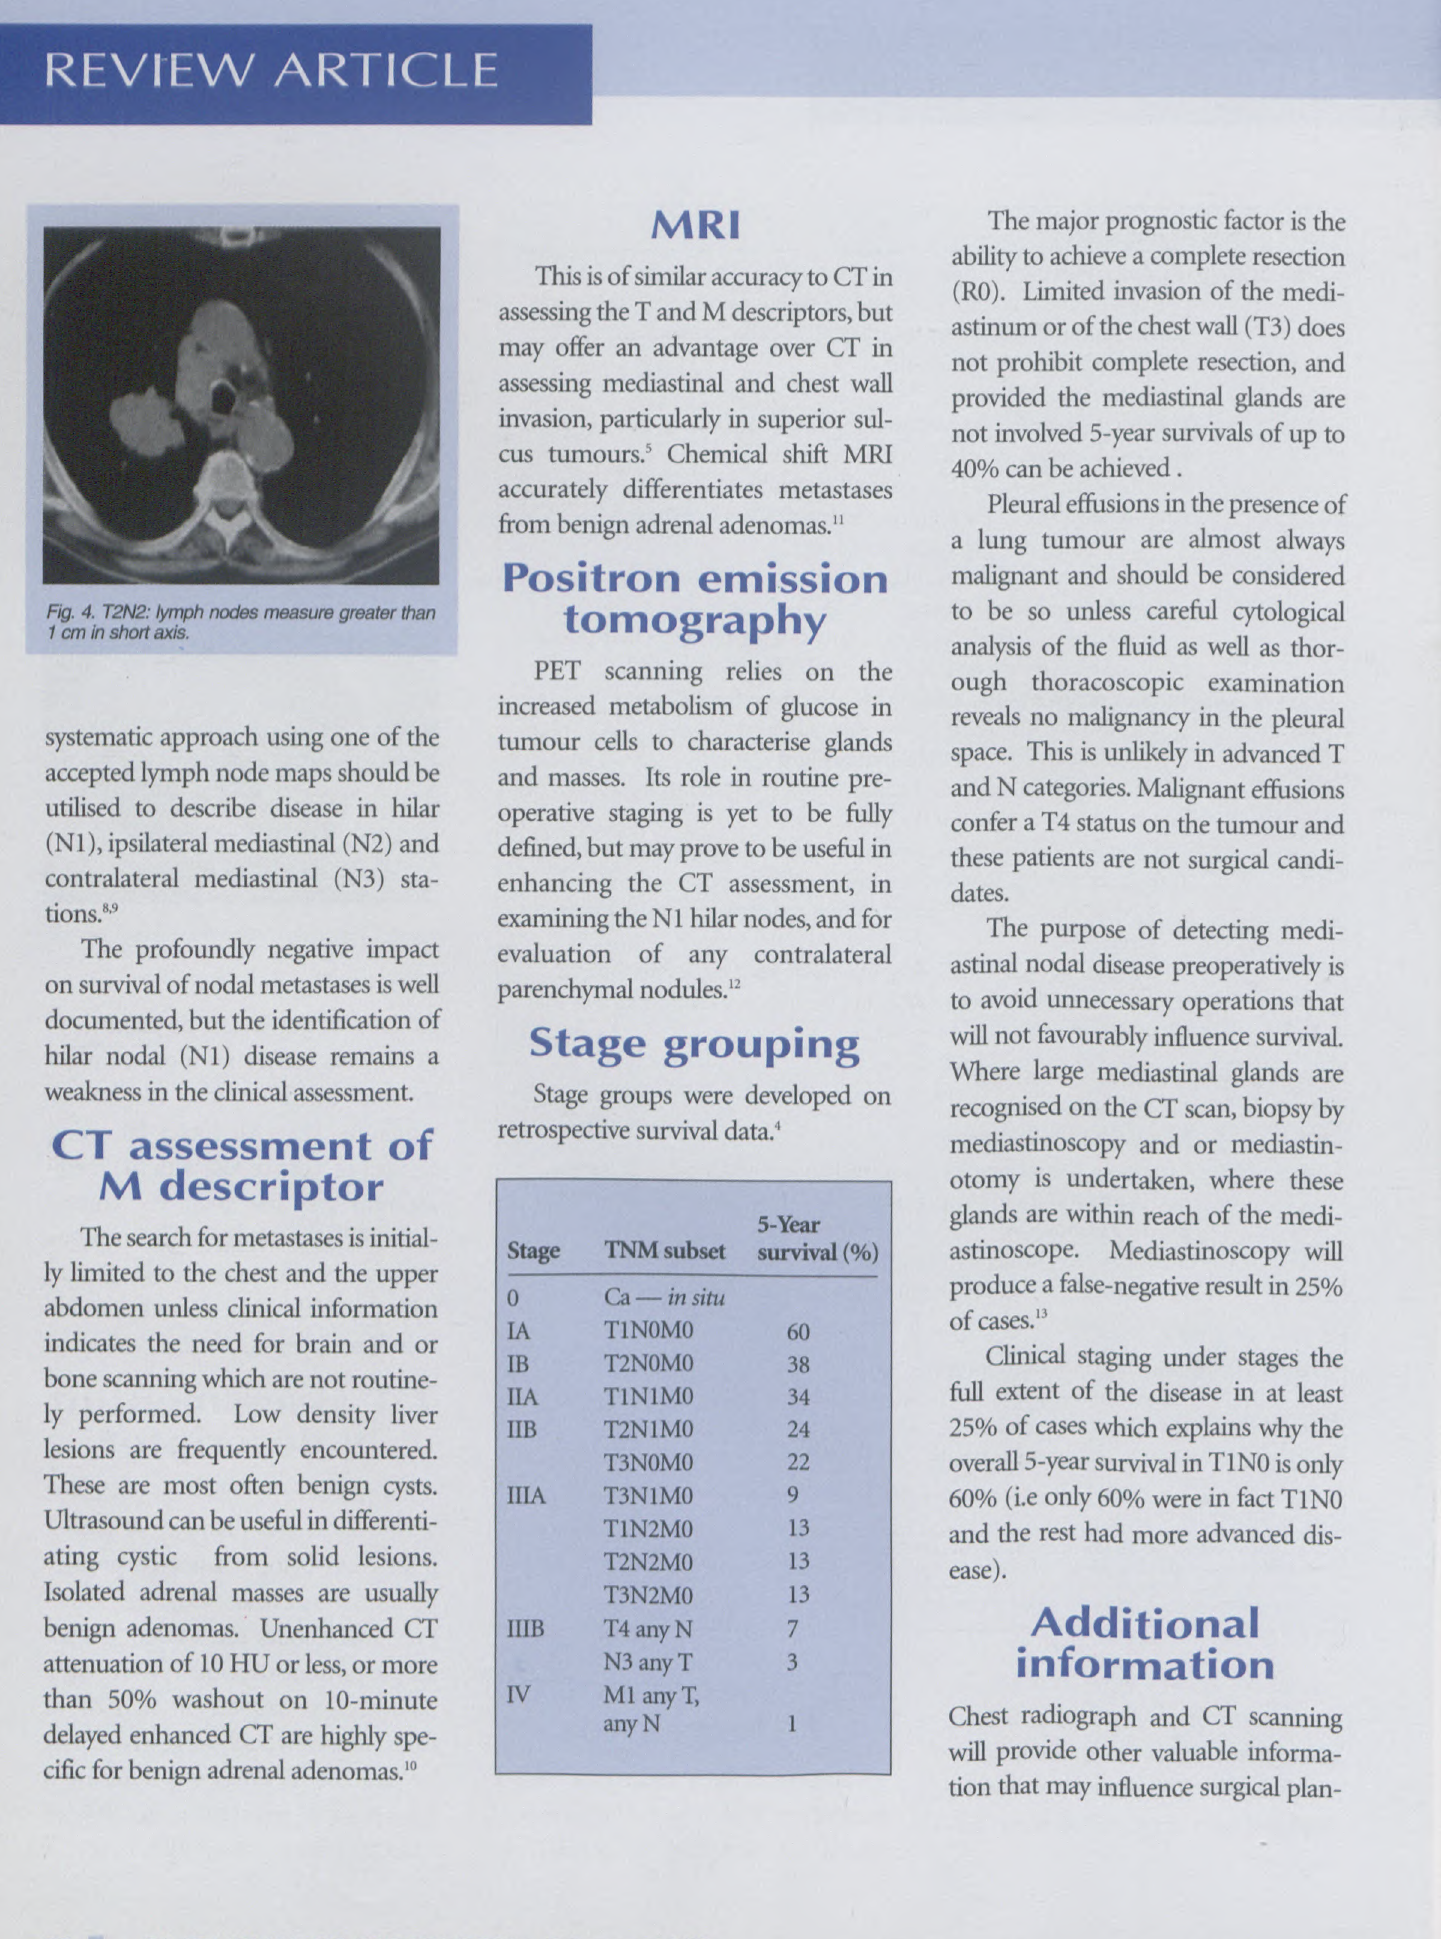
Fig. 4. T2N2: lymph nodes measure greater than 1em In short